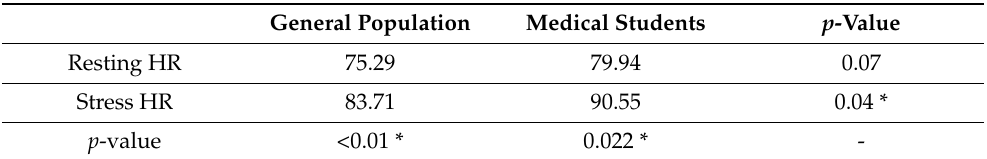
Table 3. Average heart rate for the baseline and stress phases, general population vs. medical cohort, which was recorded with FitBit Versa